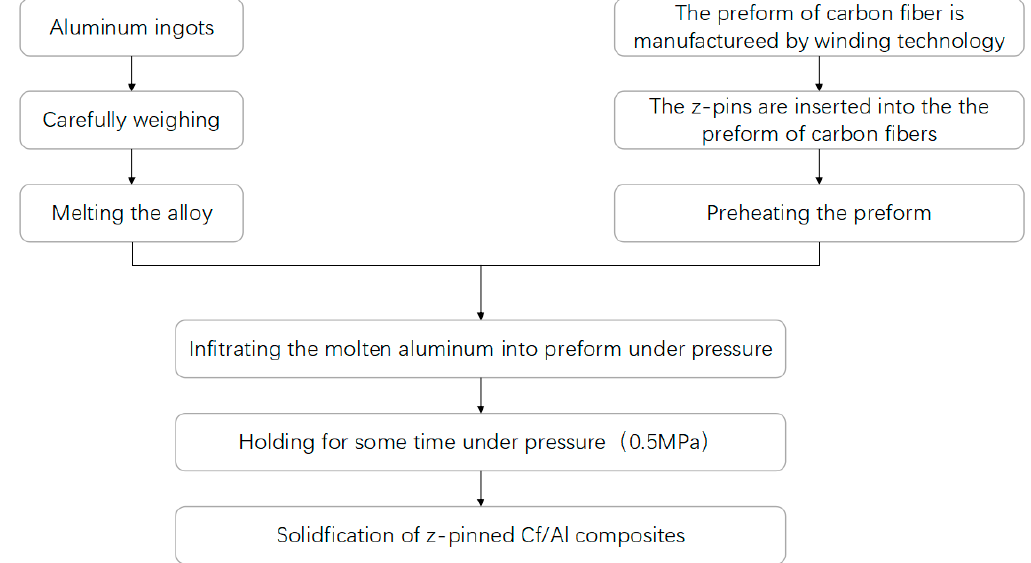
Figure 1. Fabrication procedure of z-pinned Cf/Al composites.